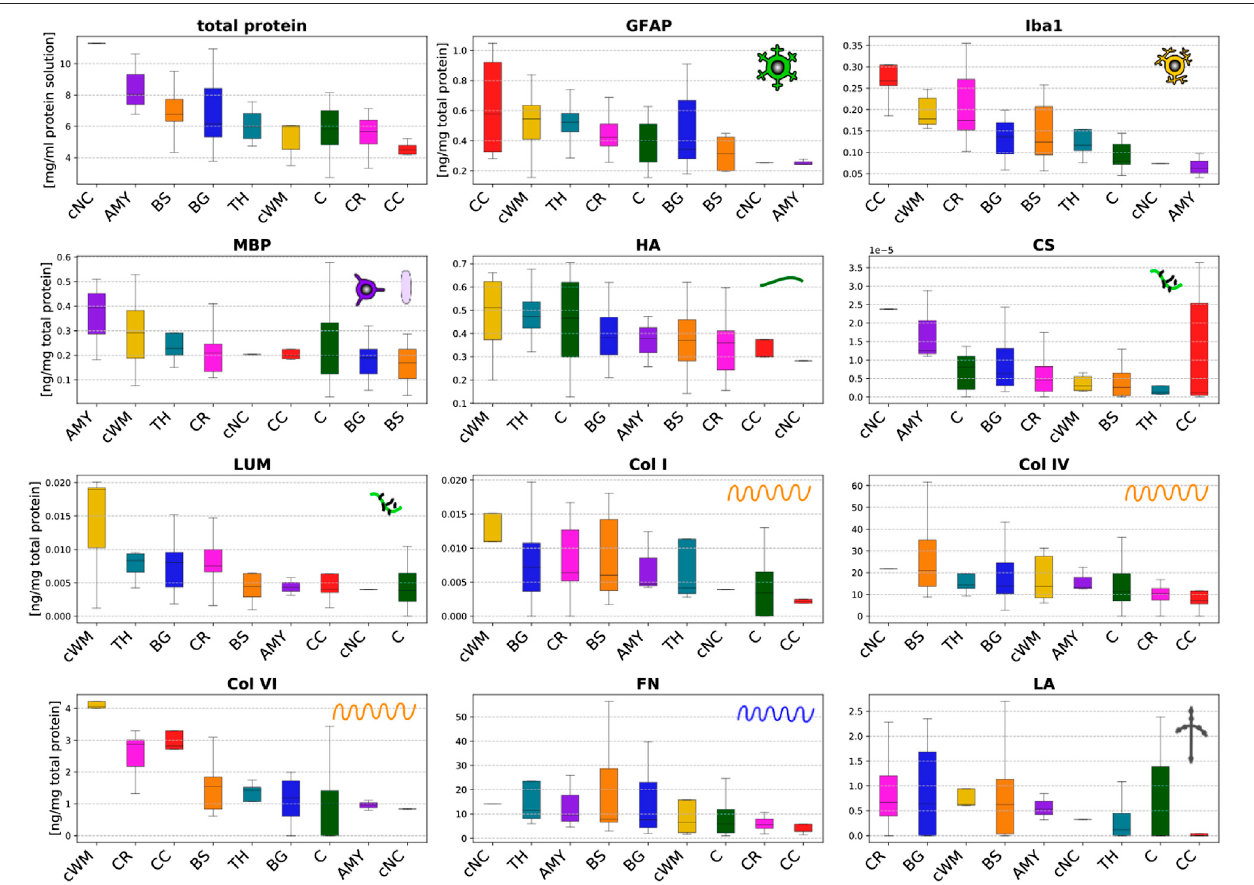
FIGURE 5 | Total protein content (upper left) and protein mass fractions of 11 species (glial fi brillary acidic protein (GFAP), microglia- and macrophage-speci fi c protein Iba1 (Iba1), myelin basic protein (MBP), hyaluronic acid (HA), chondroitin sulfate (CS), lumican (LUM), collagen I (Col I), collagen IV (Col IV), collagen VI (Col VI), fi bronectin (FN), and laminin (LA)) evaluated by ELISAs in 9 different brain regions (cortex (C), thalamus (TH), basal ganglia (BG), amygdala (AMY), cerebral white matter (CR), corpus callosum (CC), brainstem (BS), cerebellar white matter (cWM), and deep cerebellar nuclei (cNC)).